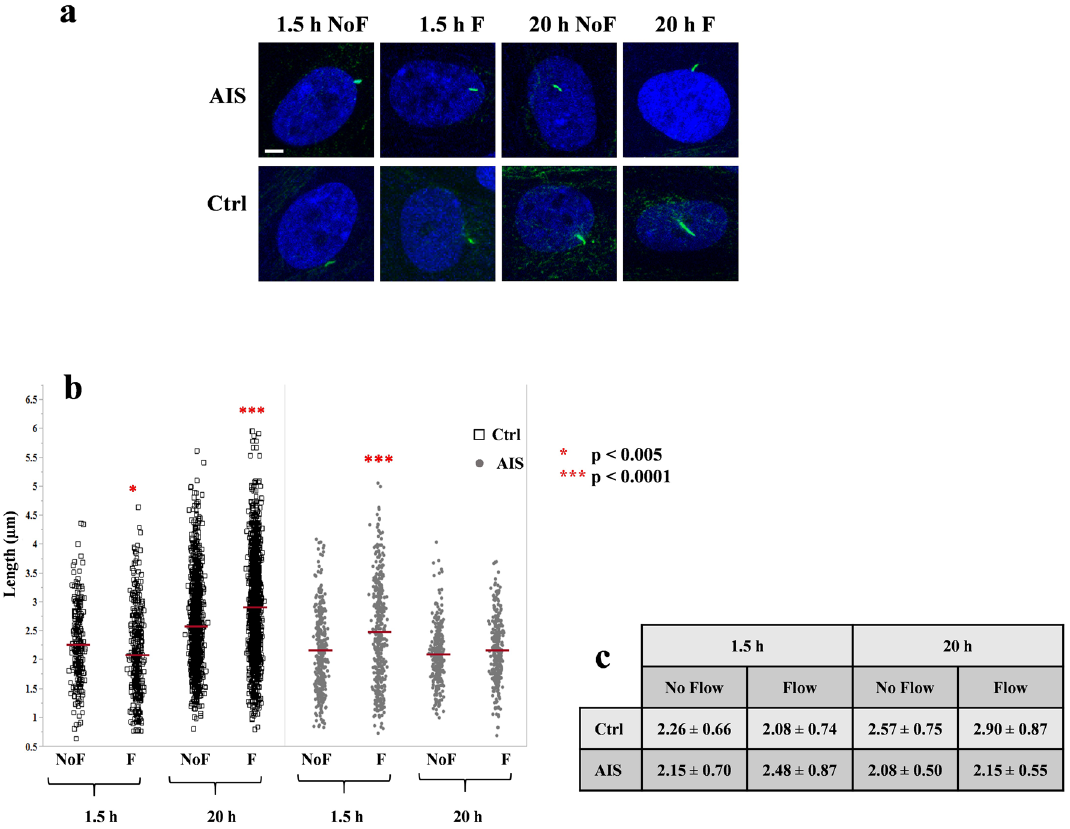
Figure 1. Flow induced primary cilia length adjustment is impaired in AIS osteoblasts. ( a ) Immunofluorescence micrographs of cilia using acetylated α-Tubulin (green) and Hoescht (blue), in AIS and control osteoblasts under static or mechanically stimulated conditions. White scale bar, 5 µm. ( b ) The dynamics of cilia length adjustment in response to flow application (F) in comparison with their static counterparts (NoF) in IS and controls. n = 4 per group, 25 fields of view, red bars represent the mean. Statistical significance was determined by Student T-test using JMP-14. ( c ) Values of the mean and standard deviation are summarized in this